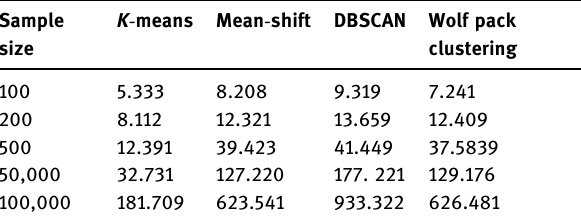
Table 5: Computation time of di ff erent clustering algorithms Sample